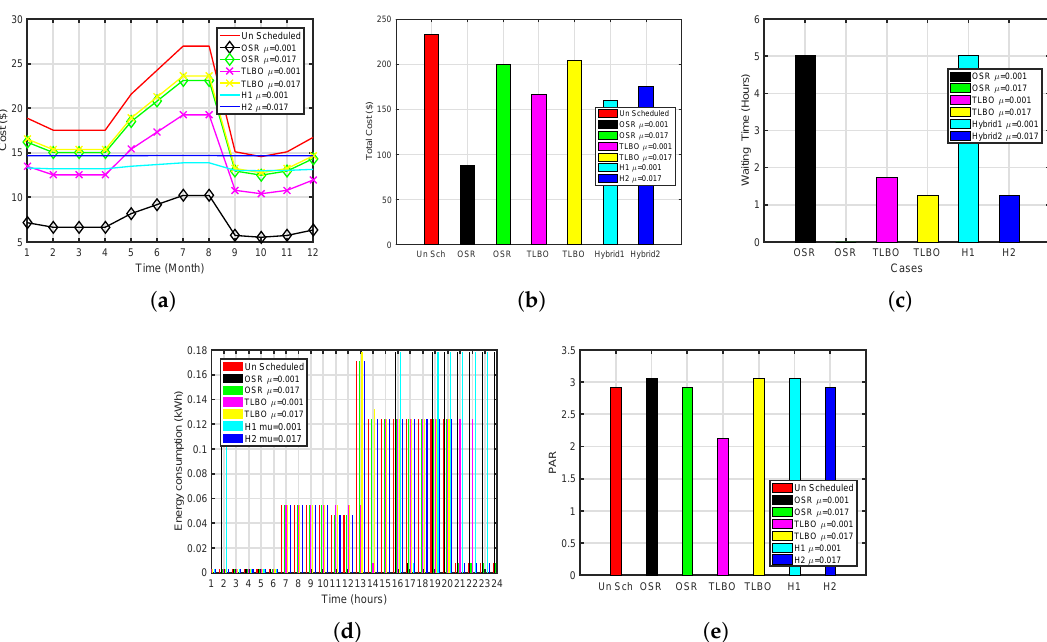
Figure 8. Hybrid Plots for Dish Washer (OSR-TLBO). ( a ) Monthly Cost of Dish Washer (OSR-TLBO), ( b ) Total Cost of Dish Washer (OSR-TLBO), ( c ) Waiting Time of Dish Washer (OSR-TLBO), ( d ) Energy Consumption of Dish Washer (OSR-TLBO), ( e ) PAR of Dish Washer (OSR-TLBO).